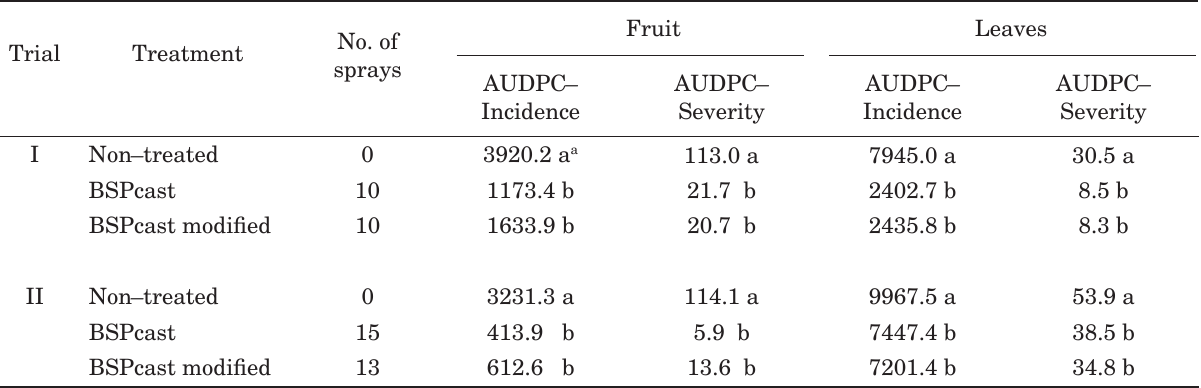
Table 2. Effect of different treatments scheduled by BSPcast or BSPcast – m on the areas under disease progress curves (AUDPC) for incidence and severity on fruit and leaves for two field